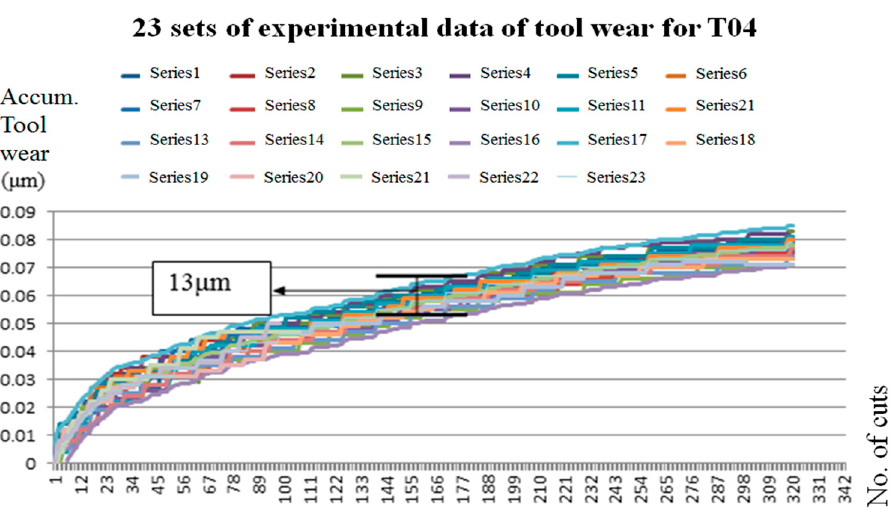
Figure 13. Statistics of tool wear for T04.